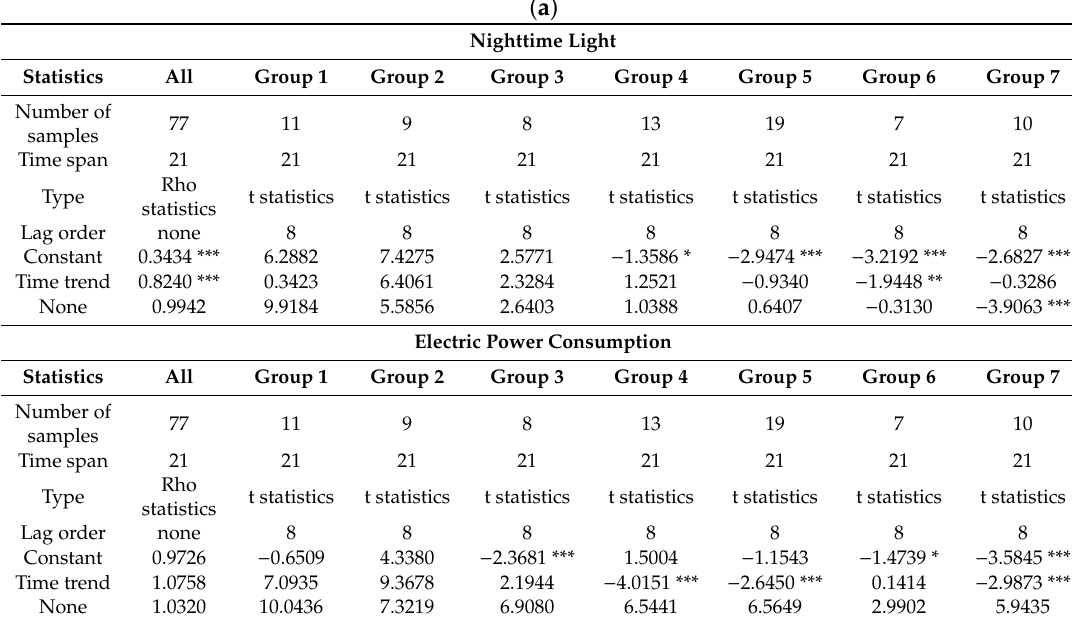
Table 5. Stationarity test. ( a ). HT and LLC tests; ( b ). ADF test. ( a )